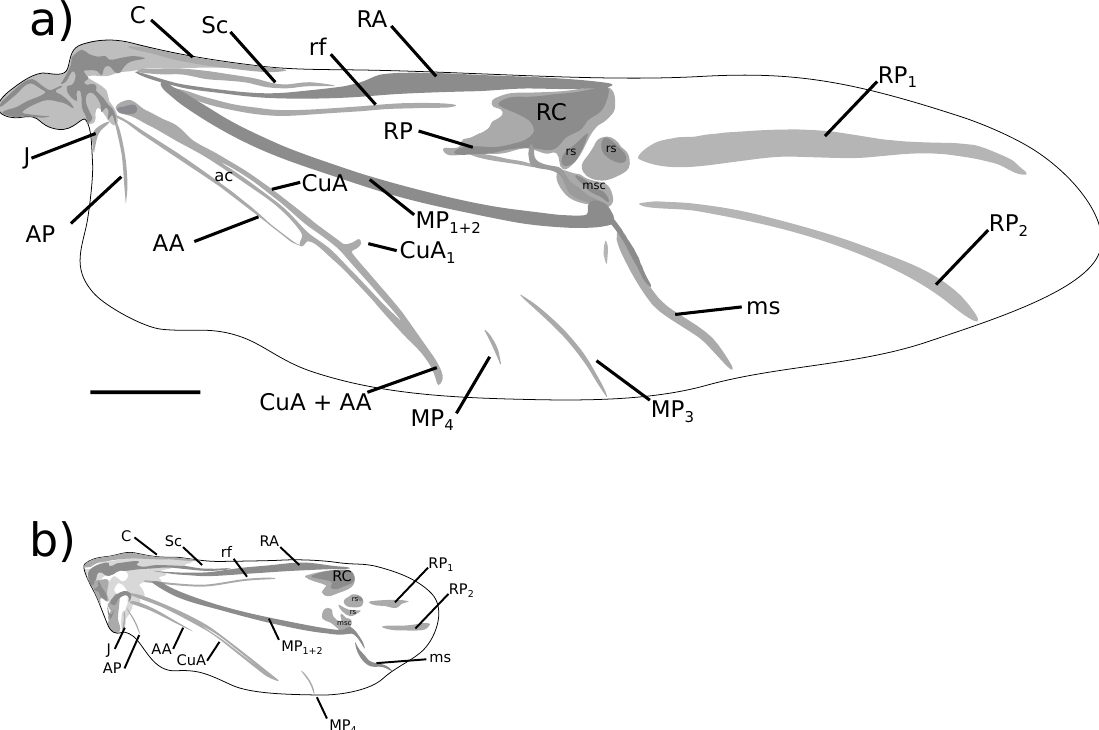
Figure 3. Hind wing of Kuschelysius species. ( a ) K. hollowayae ; ( b ) K. durus . AA: anal anterior vein; ac: anal cell; AP: anal posterior vein; C: costal vein; CuA: cubitus anterior vein; J: jugal vein; MP: media posterior veins; ms: medial spur; msc: medial sclerotisation; RA: radius anterior vein; RC: radial cell; rf: radial fold; RP: radius posterior veins; rs: radial sclerites; Sc: Subcostal vein. Wings drawn to the same scale; scale bar = 1 mm.